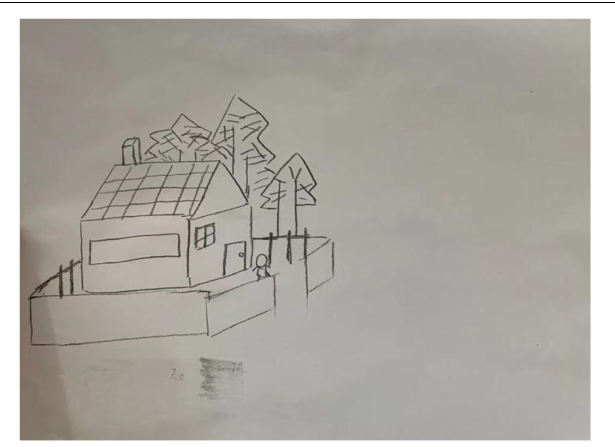
FIGURE 3 | A picture drawn by subject A3 who did not have state depression.